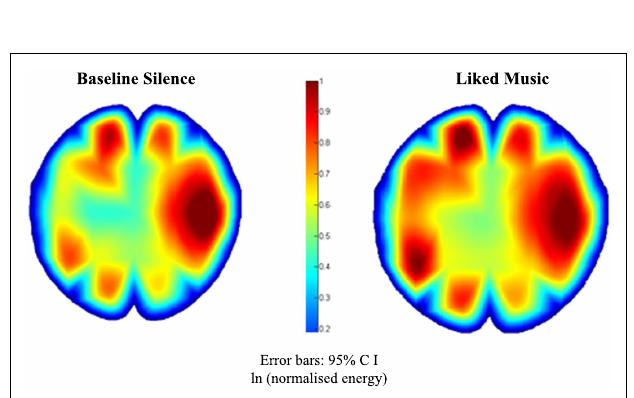
FIGURE 9 | Case “C” alpha 1 (8–10.5Hz) EEG topography